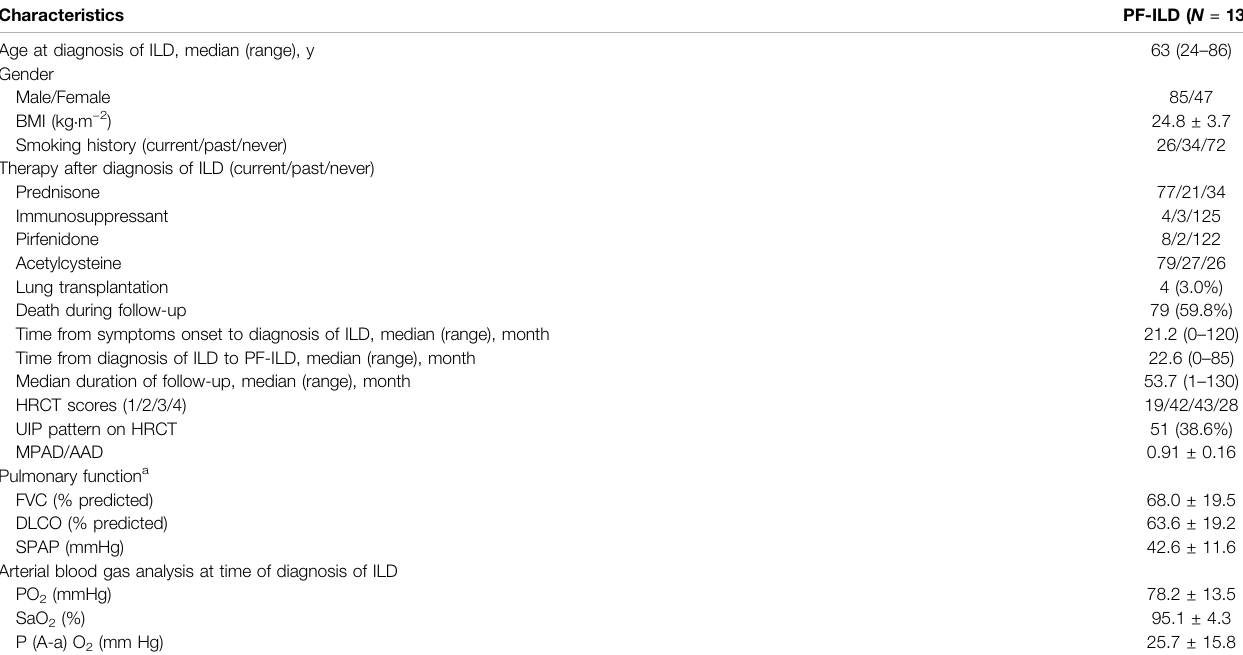
TABLE 2 | Baseline characteristics of patients with PF-ILD. Characteristics